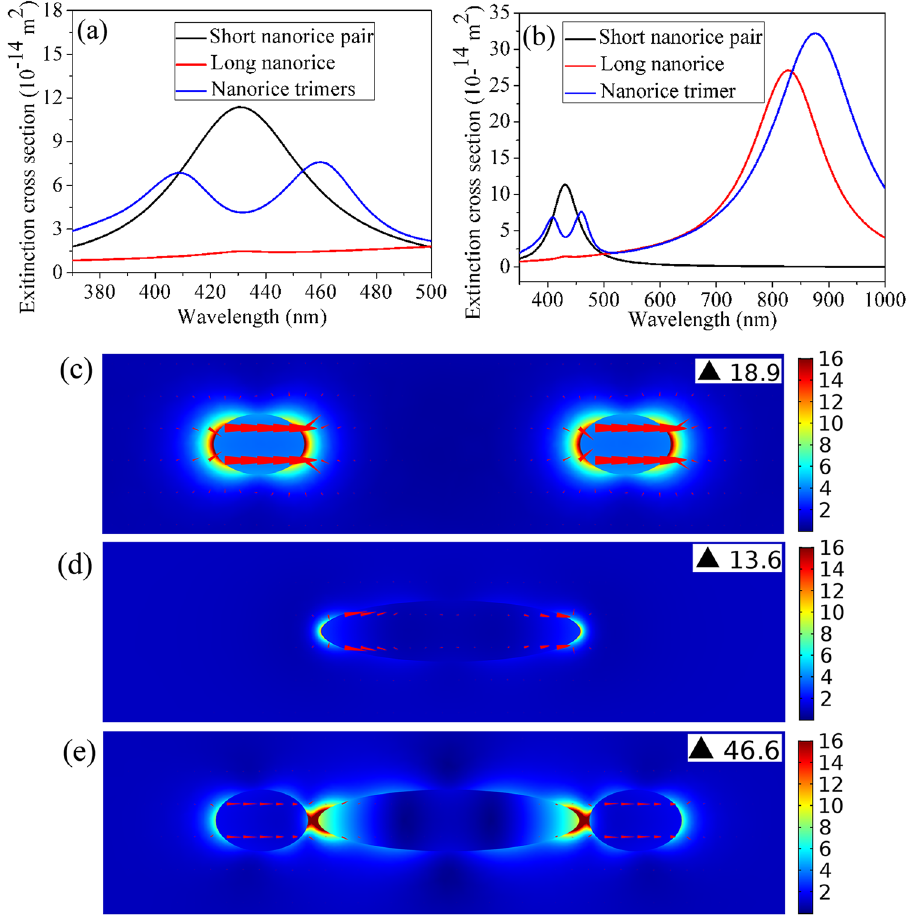
Figure 2. ( a ) Extinction cross-sections in the wavelength range from 370 to 500 nm of a silver nanorice trimer (L 1 = 254 nm, D = 60 nm, L 2 = 90 nm, g = 10 nm), short nanorice pair (L = L 2 = 90 nm, D = 60 nm, g = 274 nm) and long nanorice (L = L 1 = 254 nm, D = 60 nm). ( b ) Extinction cross-sections in the wavelength range from 350 to 1000 nm of a silver nanorice trimer, short nanorice pair and long nanorice. The field distributions of the short nanorice dimer, long nanorice and silver nanorice trimer at wavelengths of 430 nm are displayed in ( c – e ). The arrows and the size of the arrows indicate the direction and the intensity of charge oscillation, respectively. Scale factor of the arrows is 6 × 10 –5